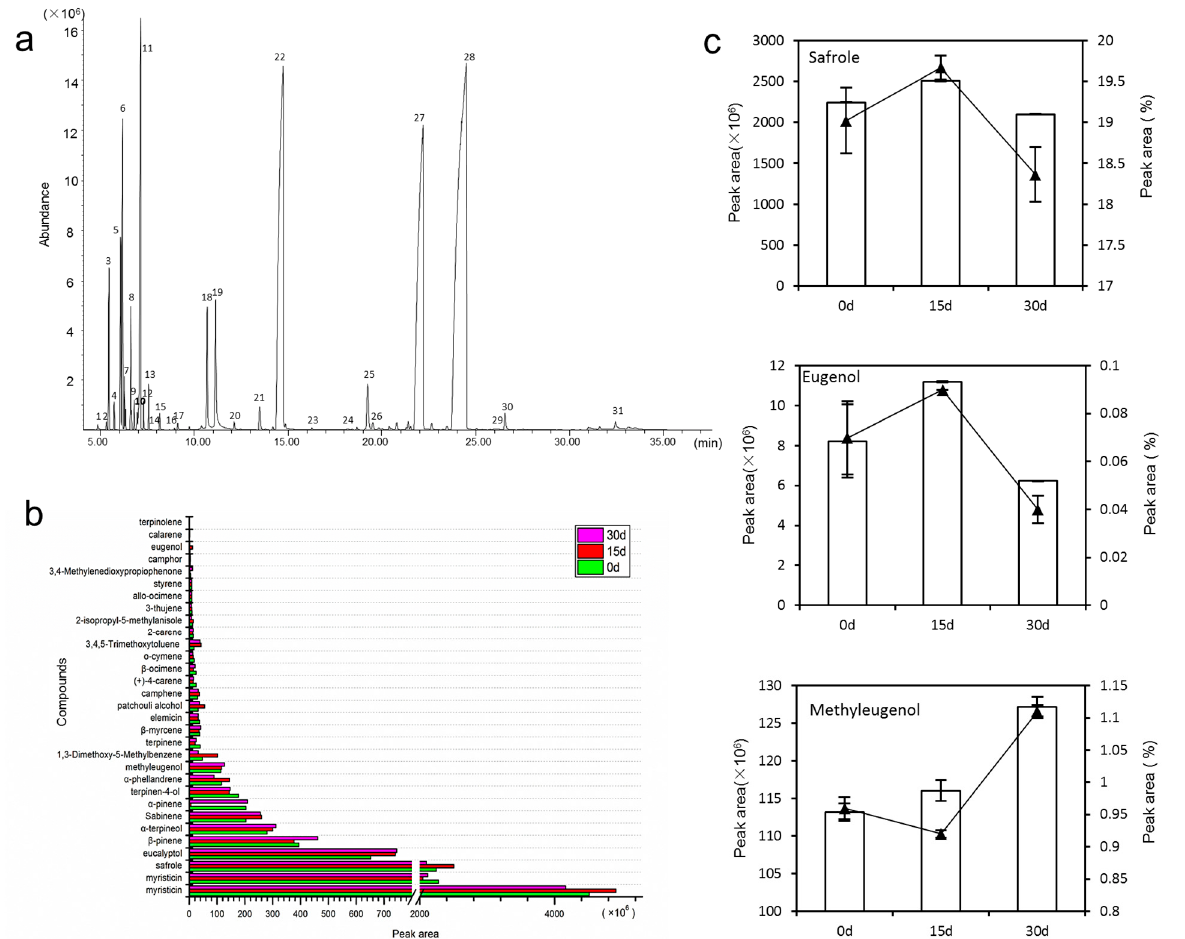
Figure 1. The changes of volatile oil content and its composition of A. sieboldii Miq. under drought stress. ( a ) the 31 components identified in volatile oil by GC-MS; ( b ) the content change in 31 components under drought and control conditions; ( c ) the relative content of safrole, eugenol and methyleugenol in drought and control.